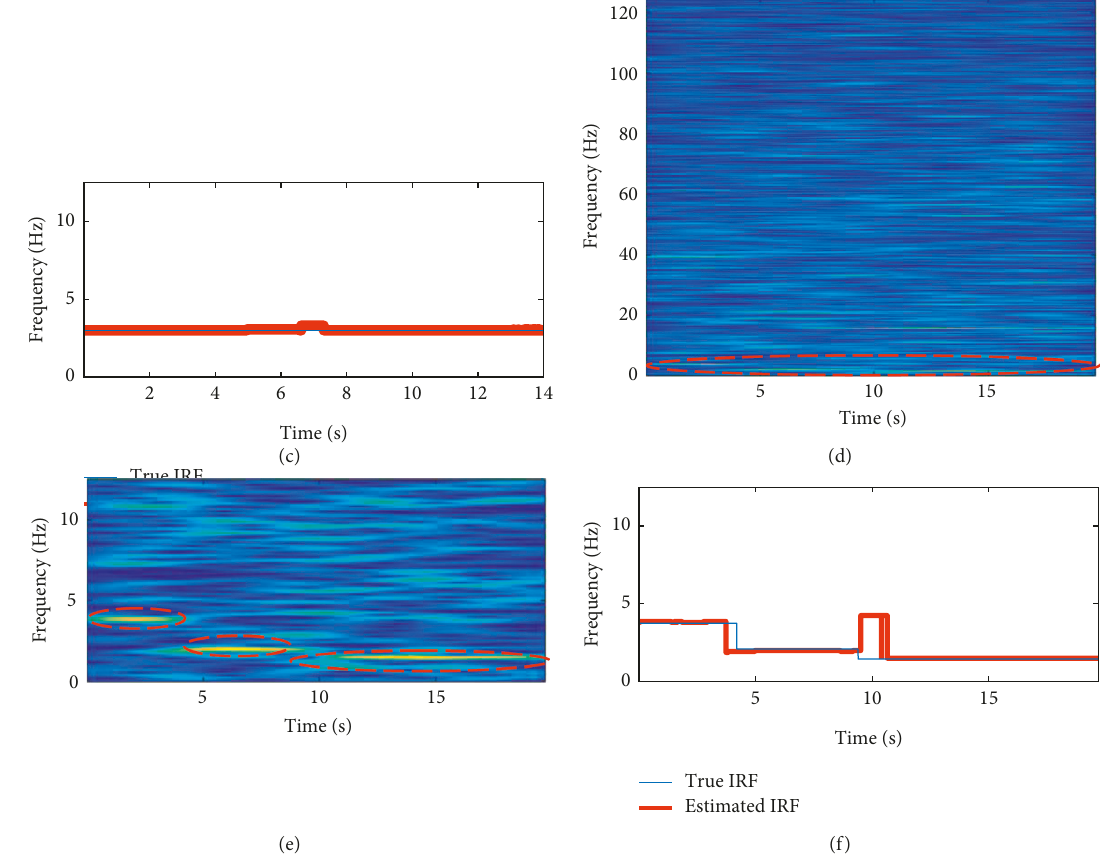
Figure 11: The results of the instantaneous rotational frequency estimation: (a) the time-frequency distribution of experiment 1; (b) the detailed time-frequency distribution of experiment 1; (c) the instantaneous rotational frequency of experiment 1; (d) the time-frequency distribution of experiment 2; (e) the detailed time-frequency distribution of experiment 2; (f) the instantaneous rotational frequency of experiment